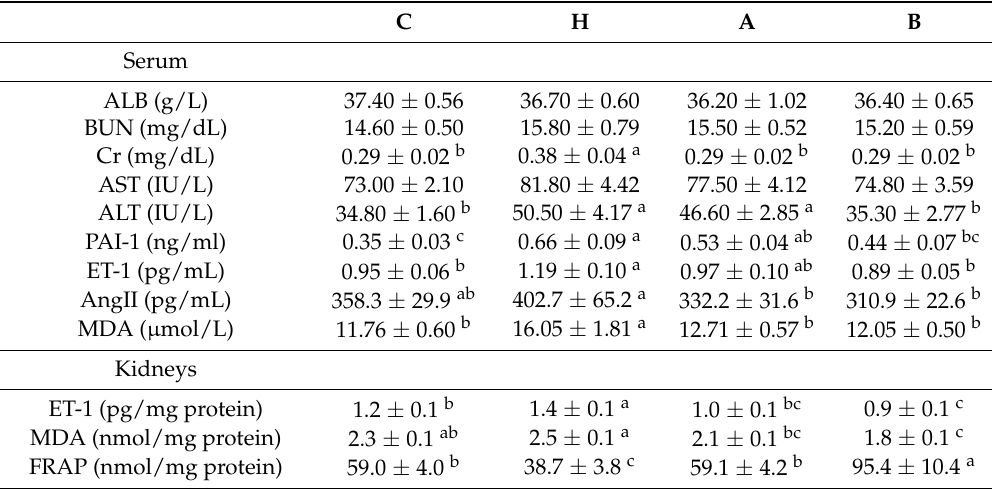
Table 1. Serum and kidney tissue injury, and oxidative and hypertensive biomarkers. C H A